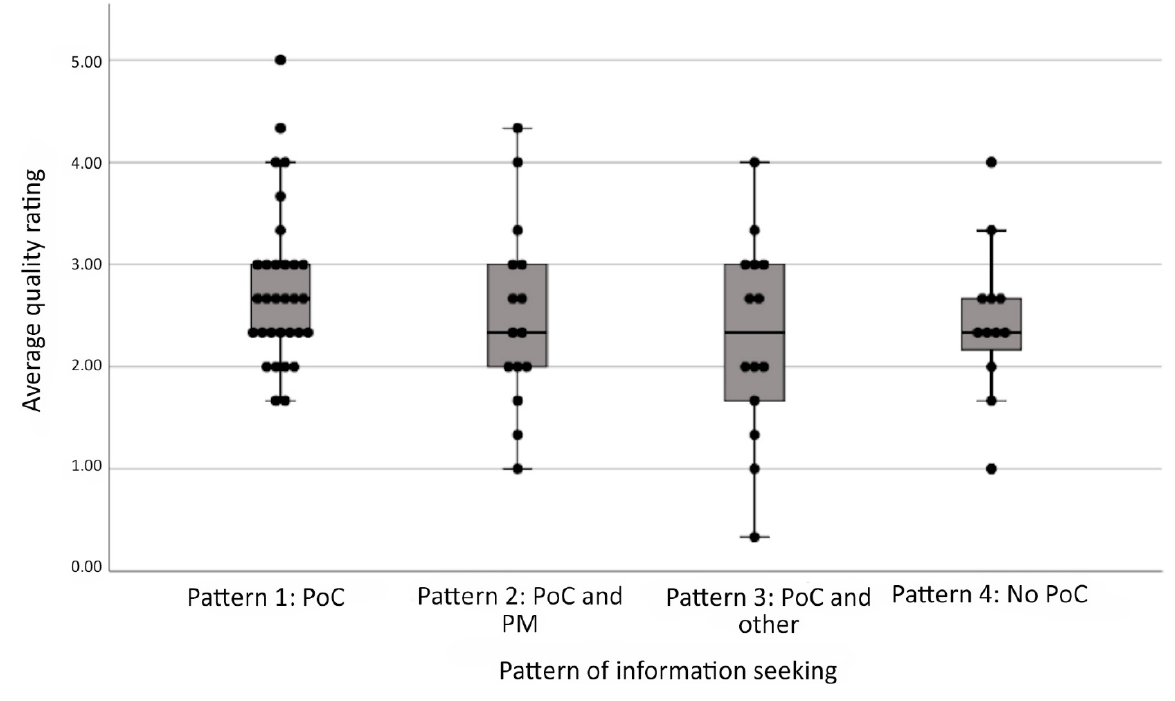
Figure 2 Average quality ratings per information seeking